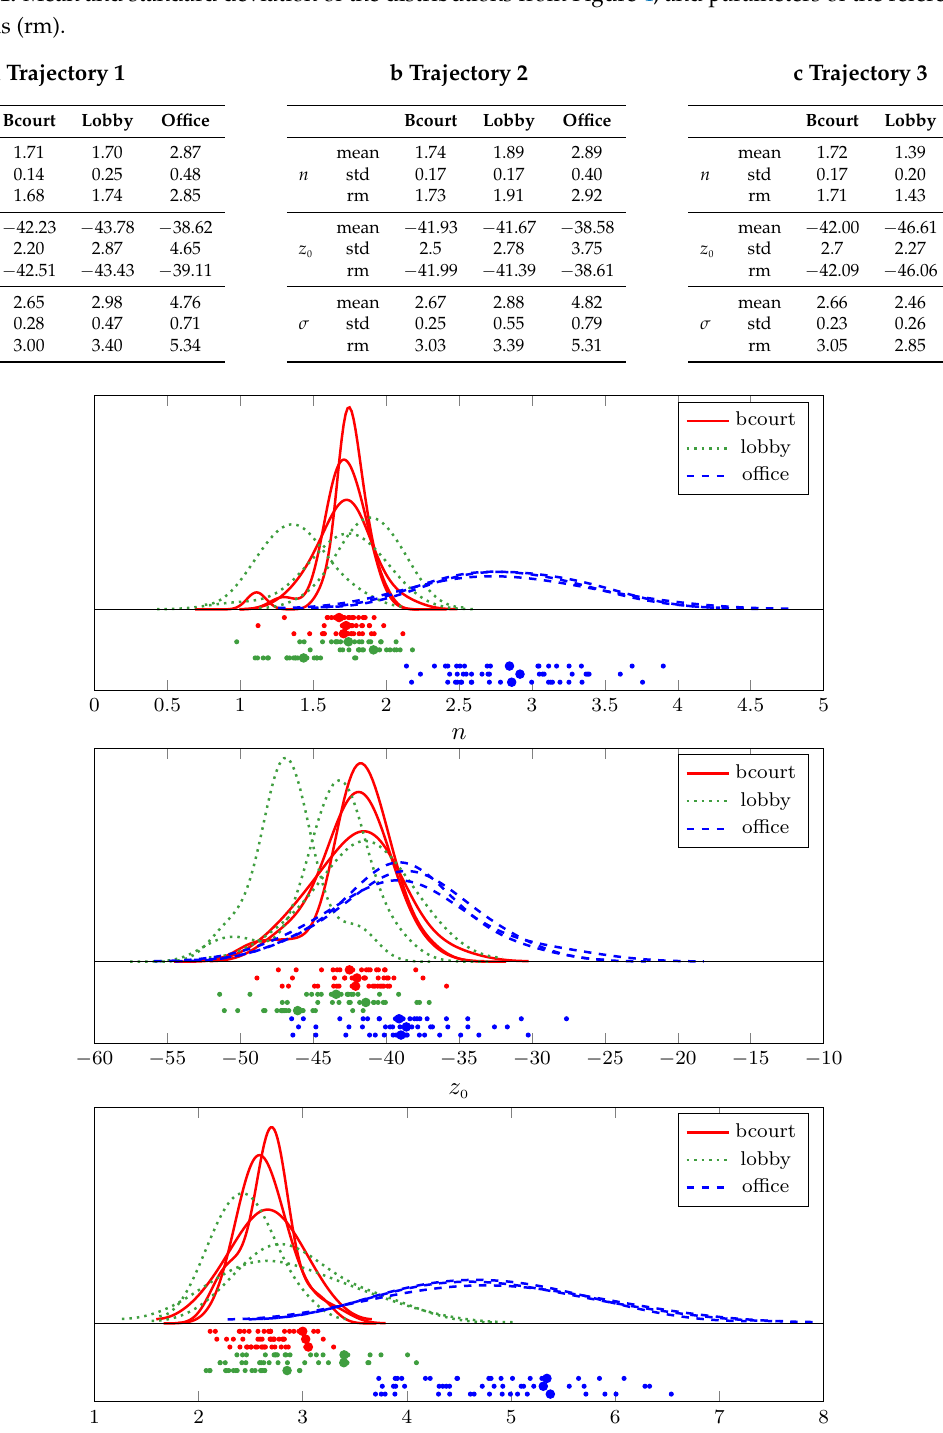
Figure 4. Reference (thick dots) and individual (thin dots) model parameters in the three environments for = 1 the three robot trajectories ( d 0